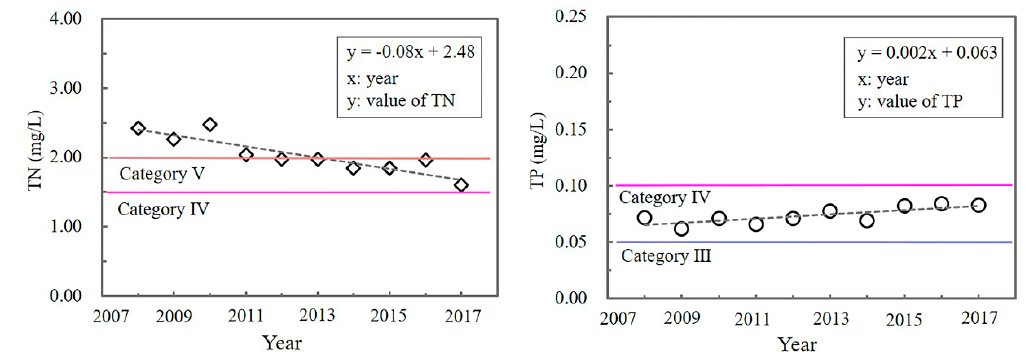
Figure 11. Different water quality indicators for Taihu Lake from 2008 to 2017. Figure 11. Di ff erent water quality indicators for Taihu Lake from 2008 to 2017.